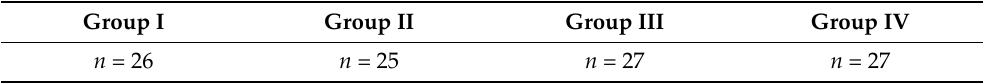
Table 2. Number of participants in each group.